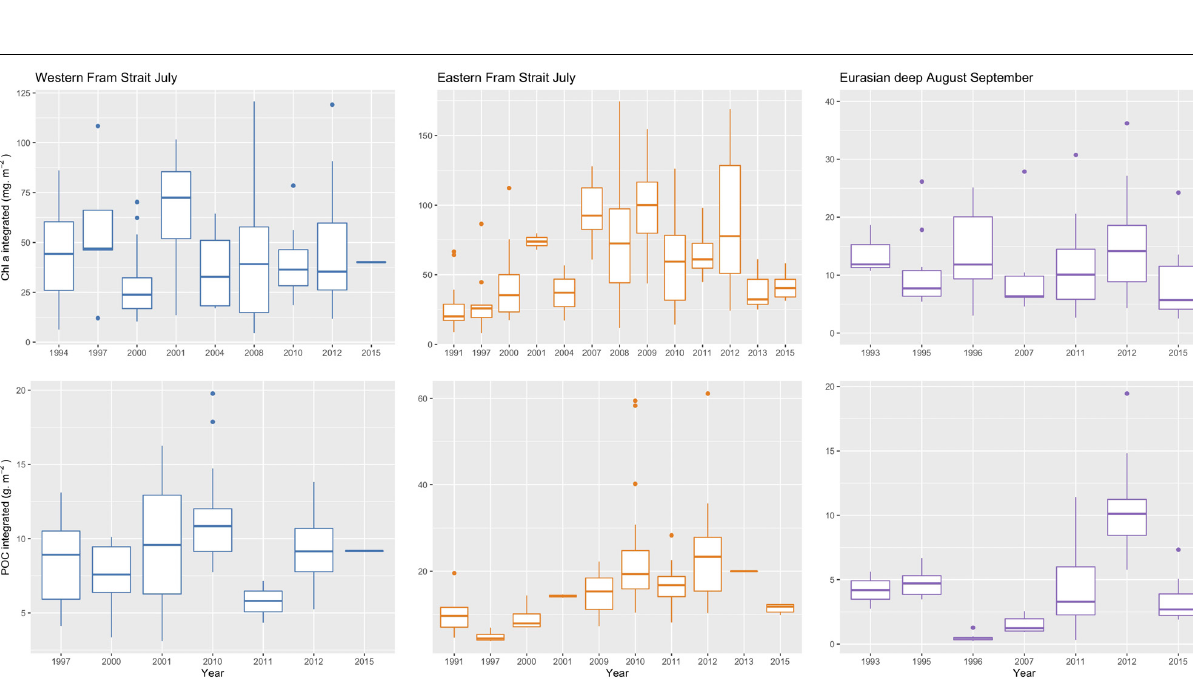
Frontiers in Marine Science |